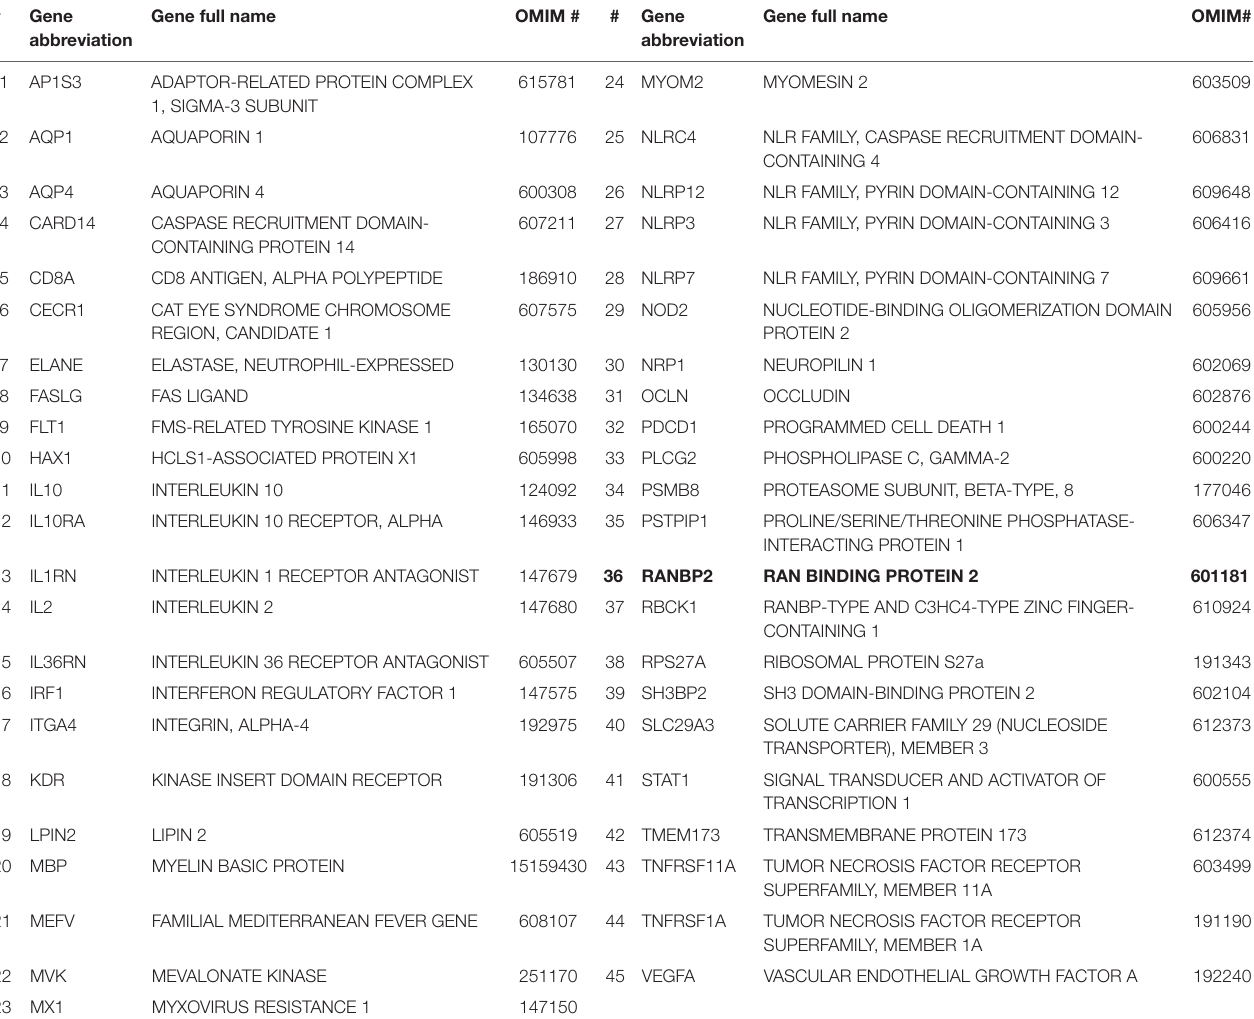
taBle 1 | List of the 45 genes associated with acute hemorrhagic encephalomyelitis/autoimmune inflammatory disorders studied in our